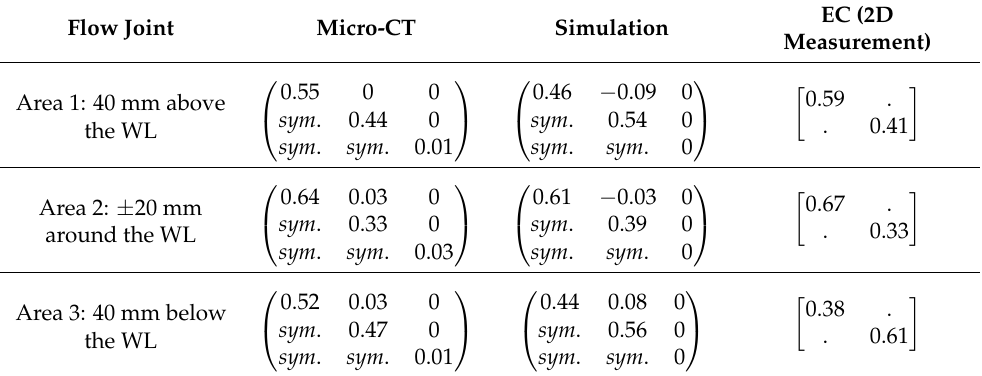
Table 6. Mean orientation tensor measured for the Flow specimen of scanned area, marked as 1, 2, and 3, using Micro-CT, simulation, and eddy current. The failure location is highlighted in red.